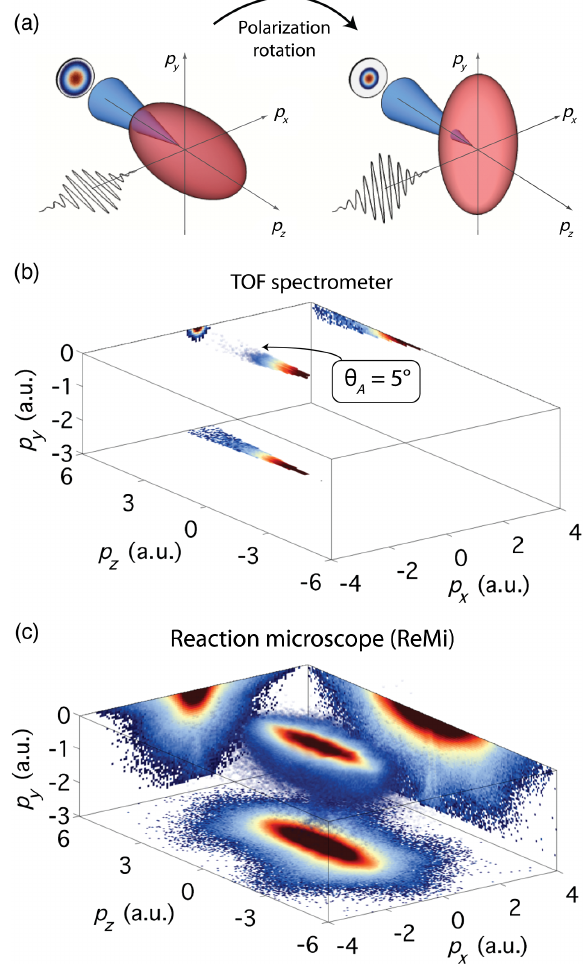
FIG. 5. (a) Only certain parts of the full 3D momentum distribution (red ellipse) can be measured by a TOF spectrometer; however, the laser polarization can be varied. After ionization of Xe using intense 3 . 1 - μ m radiation, a TOF with an acceptance angle θ A ¼ 5 ° would measure only a small portion (b) of the full 3D distribution collected by the ReMi (c). The highest measured electron momentum for this data is between 6.0 – 6.4 a.u., which corresponds to energies between 500 – 550